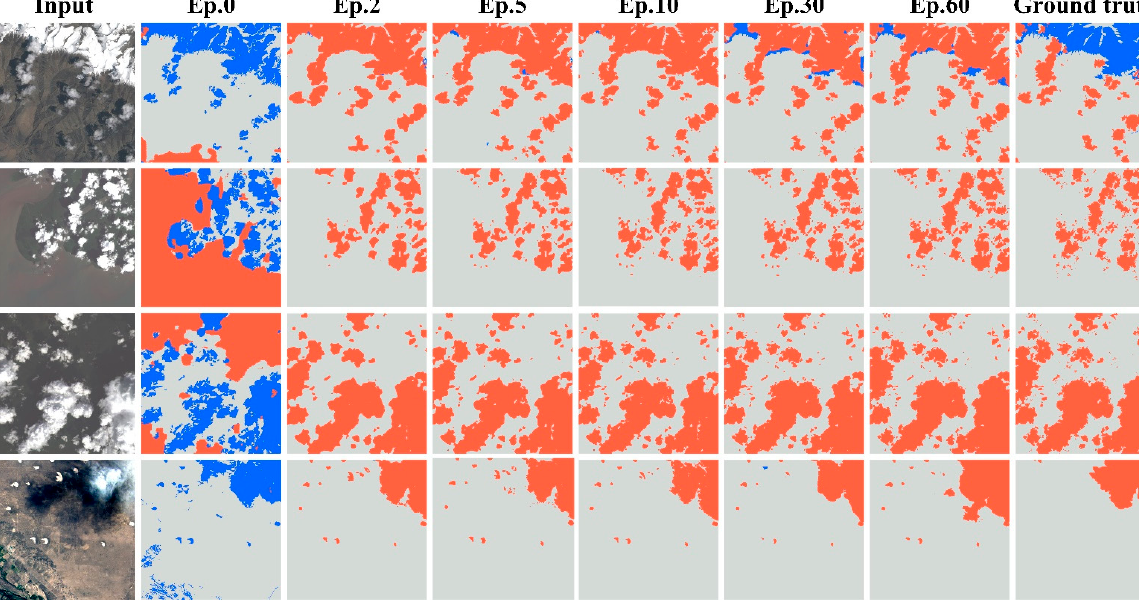
Figure 22. The examples of transfer learning prediction results on the L8_SPARCS. The number at the top indicates how many epochs of transfer learning were performed on the target dataset.